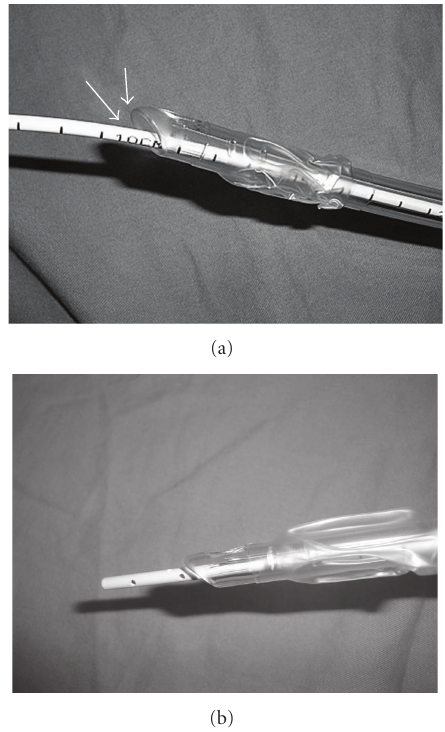
Figure 2: (a) When the OD of the AEC is significantly smaller than the ID of the tube, the tip of the tube protrudes away from the AEC and is susceptible to impingement at the glottis. (b) With the OD of the AEC relatively large compared to the ID of the tube, the tip of the tube does not protrude as much and the possibility of impingement is reduced.